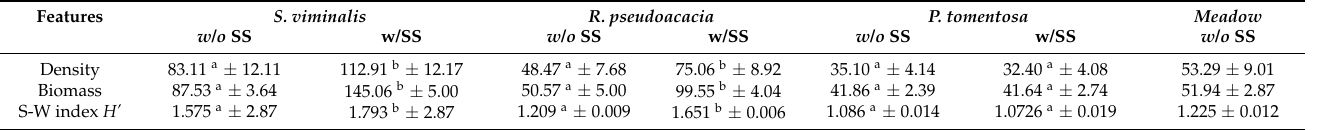
Table 3. Effect of sewage sludge on density (ind. m − 2 ), biomass (g m − 2 ), and H’ index for